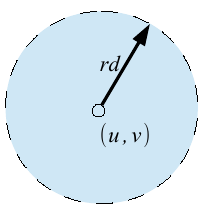
Figure 10. description of a particle by the u , v and rd parameters.